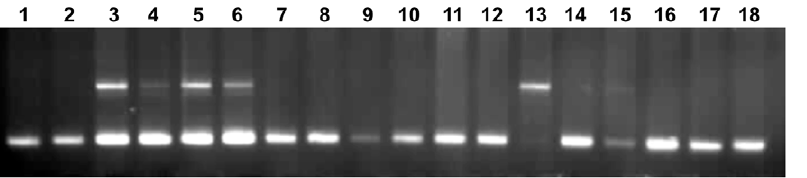
Figure 5. Gel picture showing bands for homozygotes (T1) allele, heterozygotes (T1/T2), and homozygote (T2) allele run on 2% agarose. Lane 3, 4, 5, and 6 are heterozygotes, and lane 13 is homozygous for the T2 allele and the remaining are homozygous for the T1 allele.